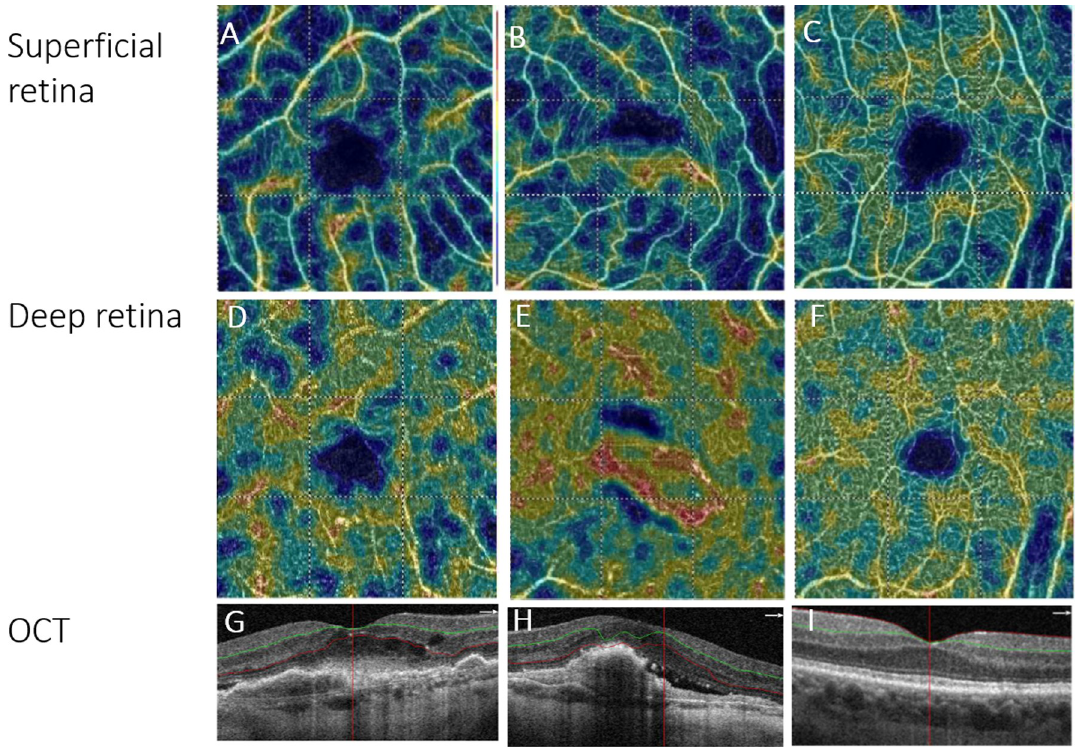
Fig 1. OCT-A imaging of the superficial (A-C) and deep (D-F) retinal capillary plexus, using the automated AngioAnalytics software in Group A (first column), B (second column) and control group (third column). Note the lower density in treated eyes, compared to control